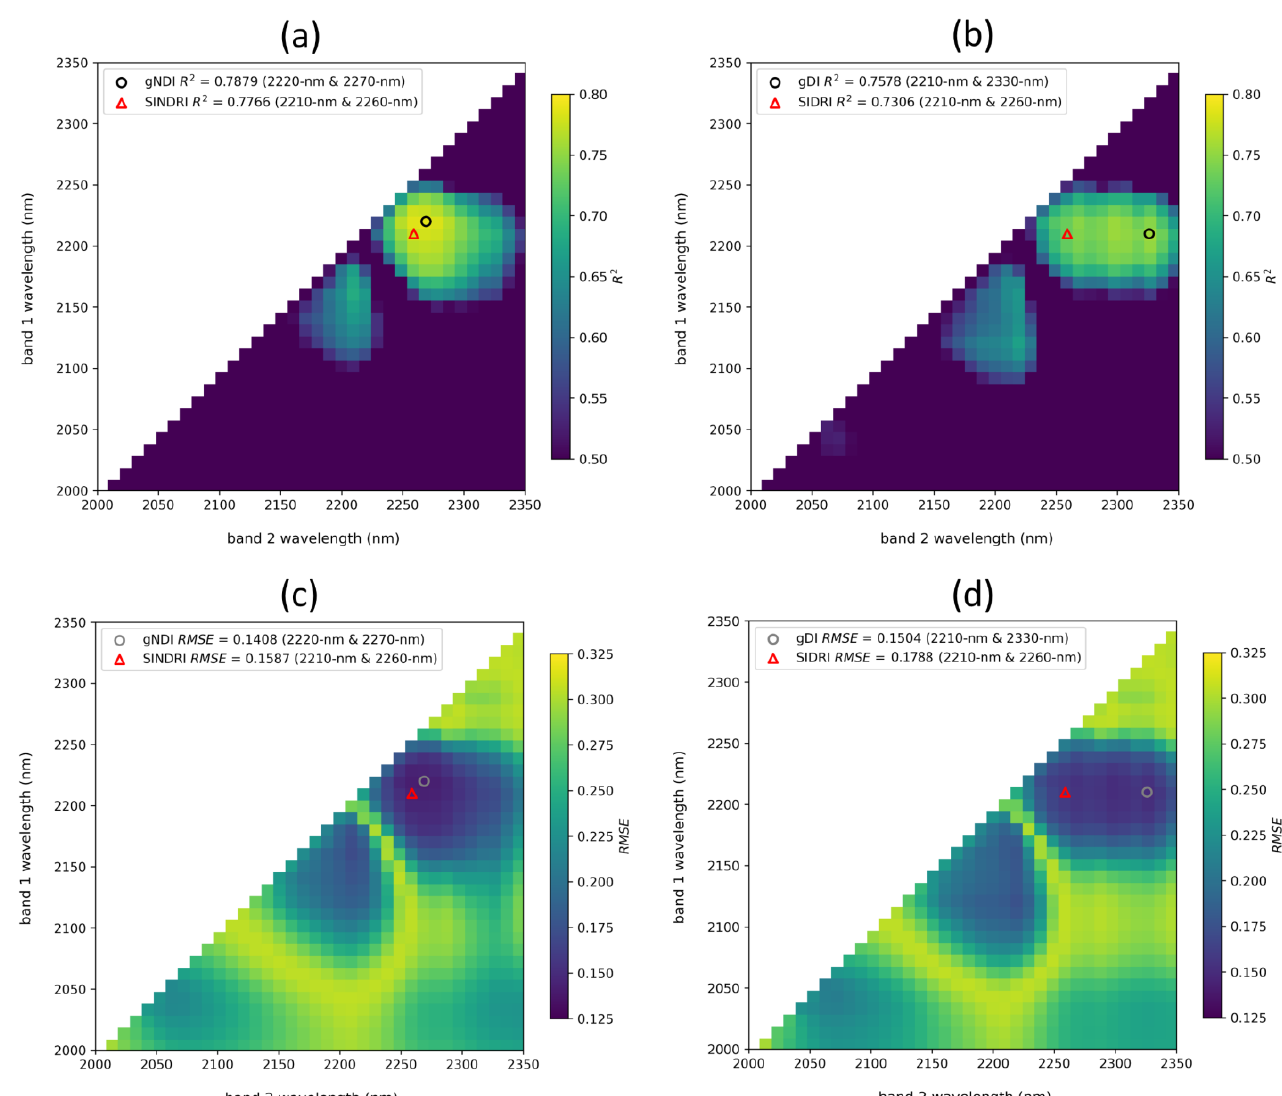
Figure 2. Performance metrics for two-band wavelength shift indices computed from the 10 nm dataset NDVI < 0.3 subset with n = 650: ( a ) gNDI- R 2 , ( b ) gDI- R 2 , ( c ) gNDI- RMSE , ( d ) gDI- RMSE . In all panels, the gray/black circles represent the band combination that produced the best f R estimation performance, as defined by the respective performance metric. The red triangles depict the band combination of a comparable heritage index. Results shown are from SR-processed spectra. The results for atm-processed spectra identified the same top-performing bands as the SR-processed spectra and are shown in Table 1. Supplementary Materials Figures S1 and S2 provide side-by-side comparisons of SR-processed (panels a and c) and atm-spectra (panels b and d)